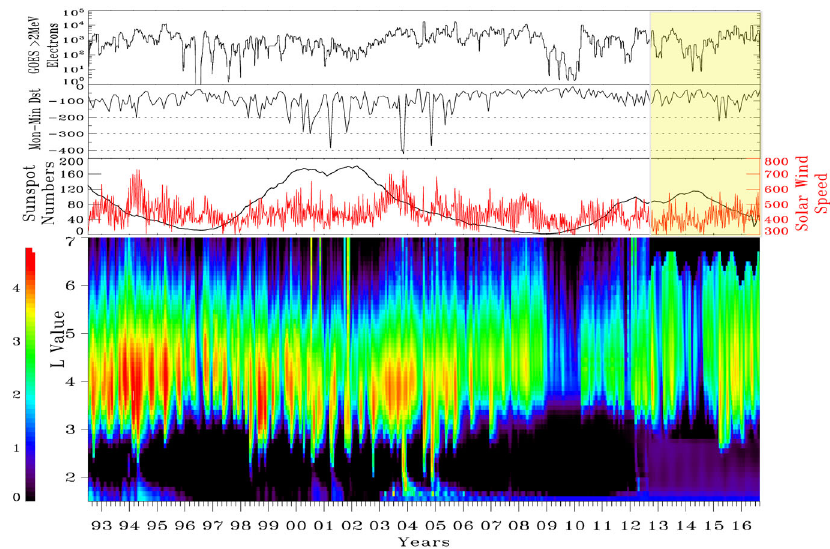
Fig. 35 Combined long-term observations as measured by SAMPEX (in low Earth polar orbit) and Van Allen Probes (in the equatorial plane; the shaded period from 2012 on). Two top panels show the 27-day window-averaged > 2-MeV electron fluxes from geostationary spacecraft GOES, and the minimum value of the 1-h Dst index each month. The third panel shows the yearly window-averaged sunspot numbers (black curve) and the weekly window-averaged solar wind speed (kms − 1 ), red curve). The bottom panels show 27-day averaged ∼ 2-MeV electron flux (units cm − 2 s − 1 sr − 1 MeV − 1 ) combined from SAMPEX and the REPT instrument on the Van Allen Probes. Image reproduced by permission from Li et al. (2017), copyright by the